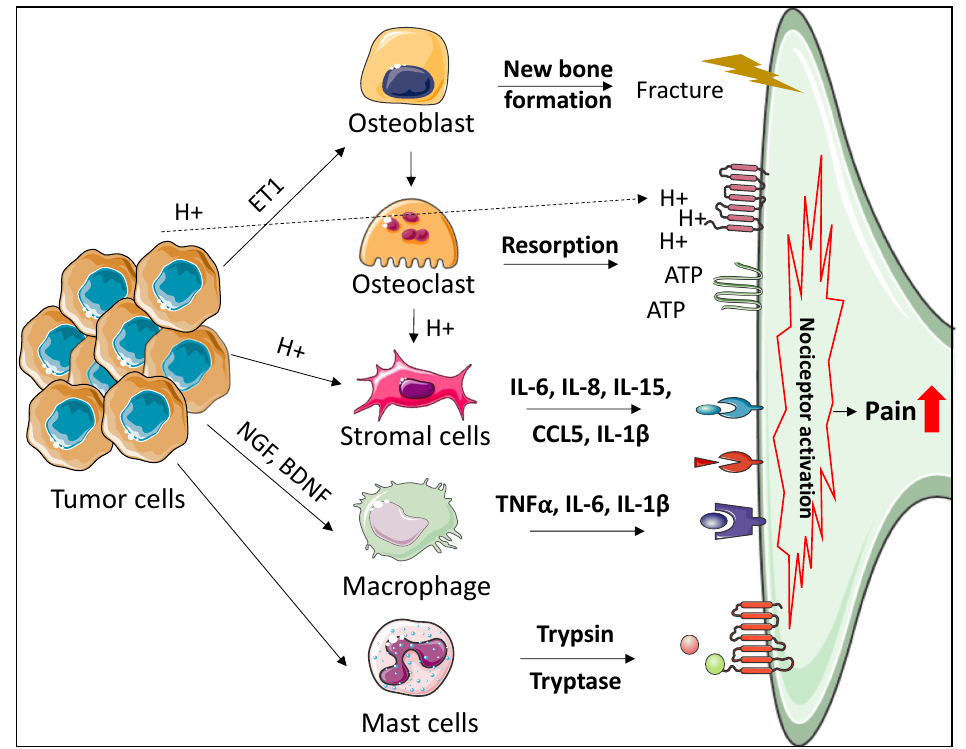
Figure 1. Mechanisms of bone microenvironment involvement in cancer-induced bone pain. Bone-disseminated tumor cells release factors (e.g., ET1) to stimulate the proliferation of osteoblasts (e.g., endothelin A/B receptors), resulting in new bone formation, which is structurally weak and prone to fracture. Active osteoblasts release RANKL to promote osteoclast activity, resulting in increased bone resorption which also weakens bone. During bone resorption, nociceptors become sensitized and activated through osteoclast mediated acidification and ATP accumulation, which activates the acid sensing TRPV1 and ASICS receptors, or the ATP-gated P2X receptors expressed on sensory neurons, respectively. Tumor cell derived H+ directly induces nociception via activation of the acid sensing receptors expressed on the sensory neurons. Stromal cells (e.g., fibroblasts and mesenchymal stem cells) also express acid sensing receptors, and acidification of the bone marrow space stimulates release of stromal cell derived pro-inflammatory cytokines (IL-6, IL-8, IL-15, CCL5, IL-1 β ) and nociceptive mediators (NGF and BDNF). Tumor cells also express NGF and BDNF, which activate macrophages to release pro-inflammatory cytokines (TNF- α , IL-6, IL-1 β ) and inflammatory regulators (NGF and Prostaglandins) which directly induce pain via binding to their receptors on sensory neurons. Finally, tumor cells interact with peri-neural and tumor-infiltrated mast cells, releasing mast cell derived proteases (trypsin and tryptase) which activate sensory neurons by binding to PAR-2 receptor, resulting in pain and upregulation of pain-related neuropeptides (CGRP and